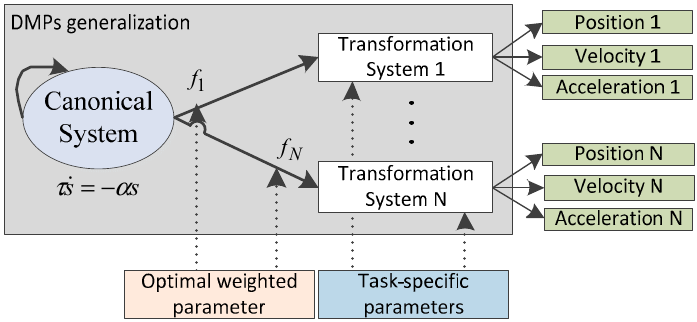
Figure 2. Multiple degrees of freedom schematic in DMPs generalization.